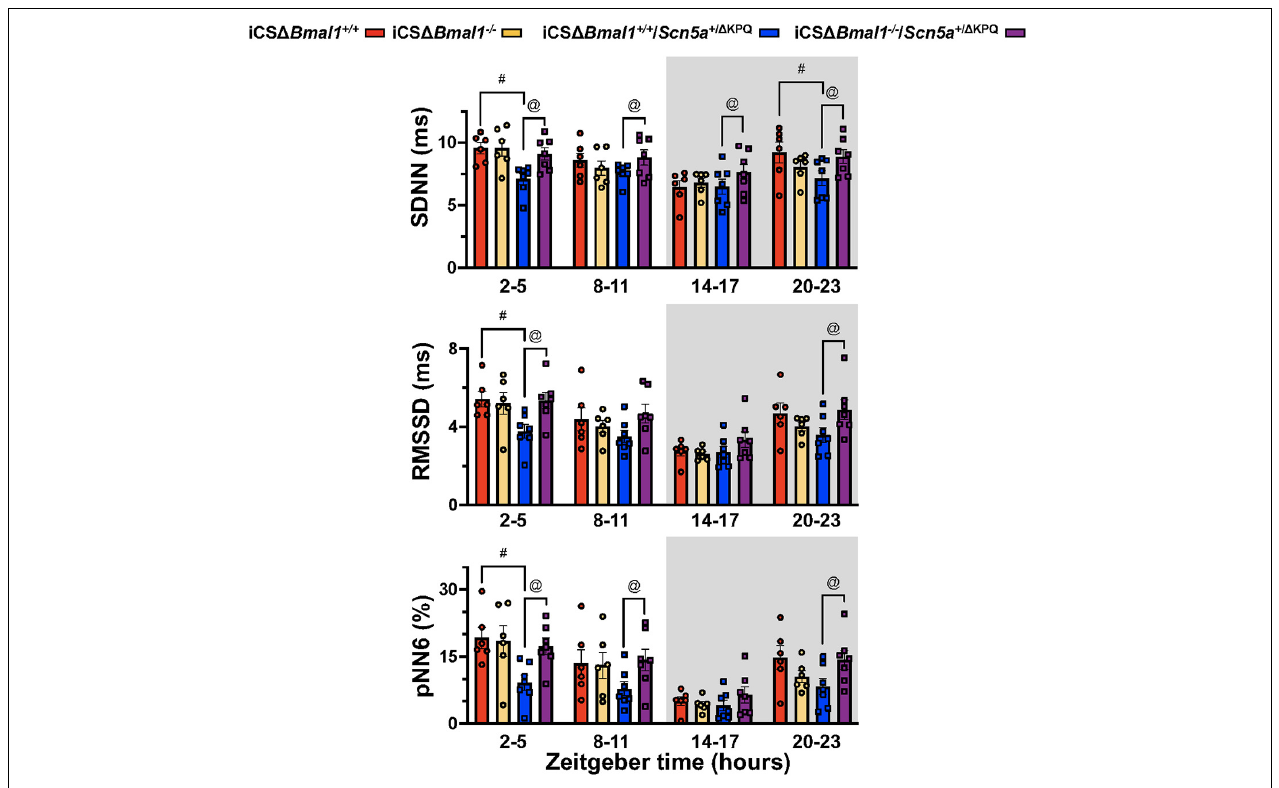
FIGURE 4 | Mice with the (cid:49) KPQ- Scn5a mutation have reduced HRV and this is increased by inducing the deletion of Bmal1 in adult cardiomyocytes. The graphical representation of the change SDNN (top graph), RMSD (middle graph) or pNN6 (bottom graph) for iCS (cid:49) Bmal1 + / + (red bars, circles), iCS (cid:49) Bmal1 − / − (orange bars, circles), or iCS (cid:49) Bmal1 + / + /Scn5a + /(cid:49) KPQ (blue bars, circles), and iCS (cid:49) Bmal1 − / − /Scn5a + /(cid:49) KPQ (purple bars, circles) mice measured at ZT = 2–5, 8–11, 14–17, and 20–23 h are shown ( n = 6 and n = 7, respectively). Analysis detected differences in the SDNN, RMSSD and PNN6 between iCS (cid:49) Bmal1 + / + and iCS (cid:49) Bmal1 + / + /Scn5a + /(cid:49) KPQ mice ( # p < 0.05) at certain timepoints, as well as differences in the SDNN, RMSSD and PNN6 between iCS (cid:49) Bmal1 + / + /Scn5a + /(cid:49) KPQ and iCS (cid:49) Bmal1 − / − /Scn5a + /(cid:49) KPQ mice ( @ p <